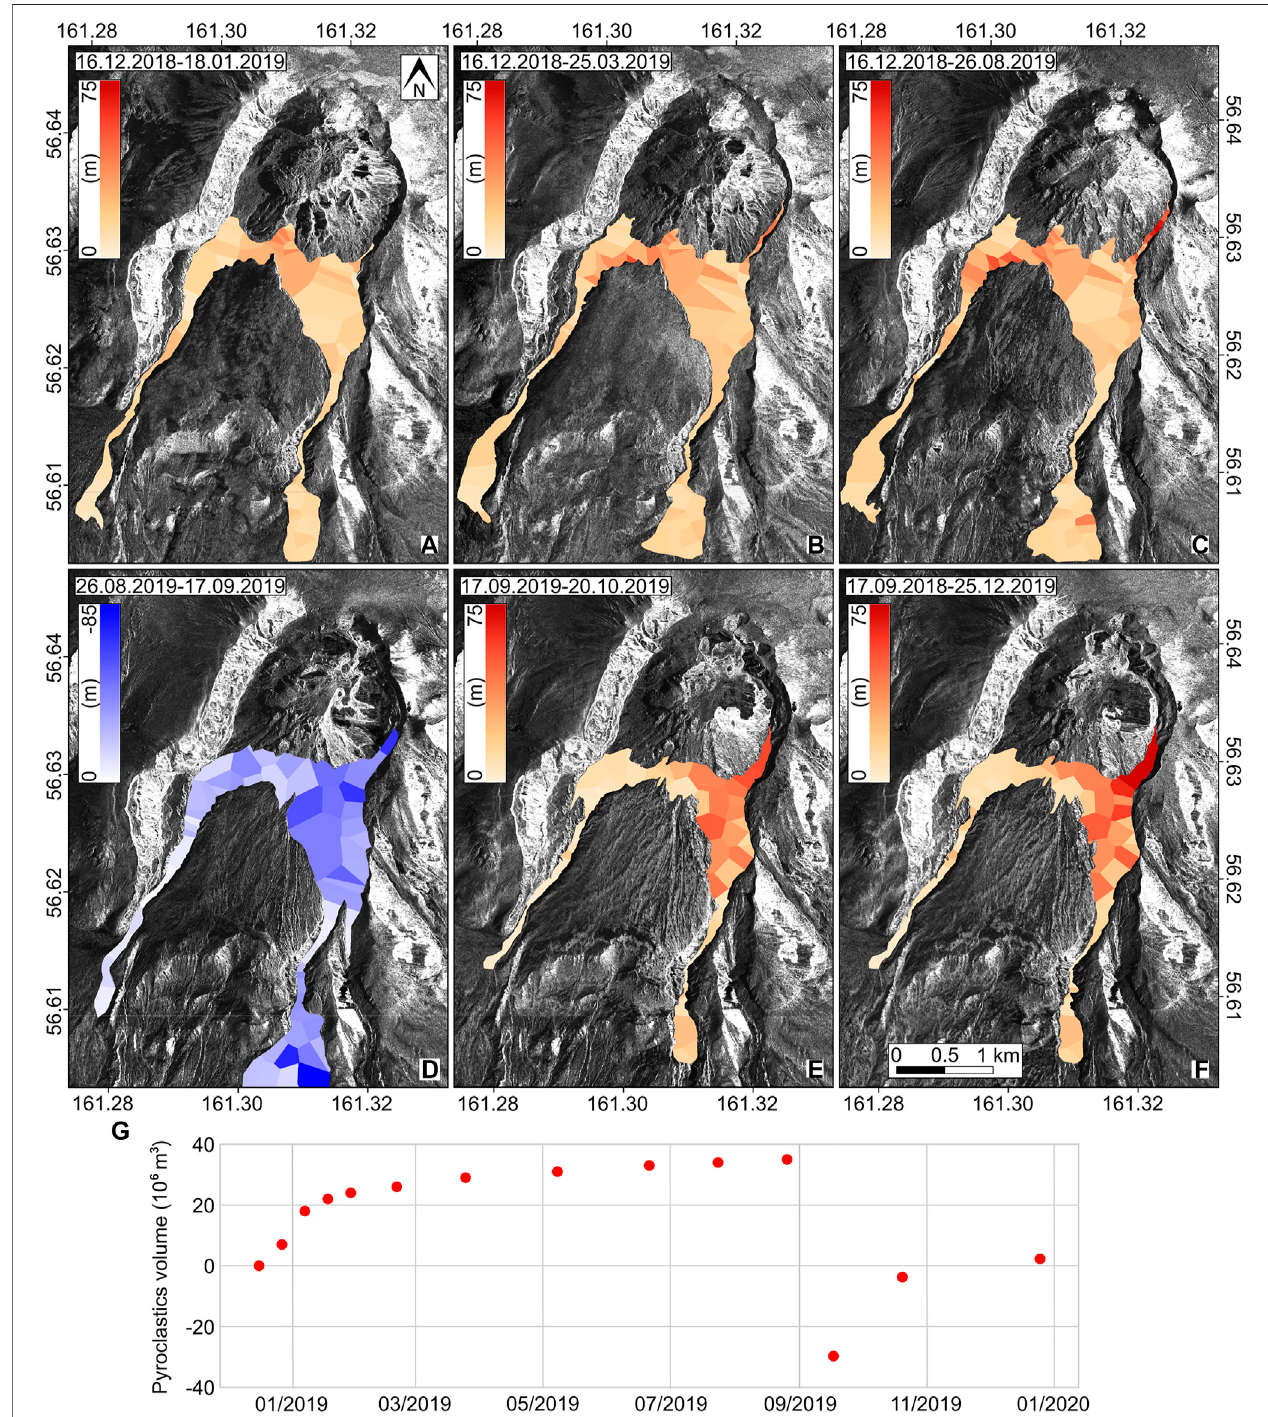
FIGURE 9 | Time series of the minimum deposit thickness within the 2005 and 2010 collapse scars estimated using the radar shadow method for several SAR acquisitions between December 2018 and December 2019 (see Data and Methods SAR Data and Monitoring the Material Redistribution ( b )). Reddish and bluish polygons show the Voronoi diagram approximations of the area of accumulation and removal of material, respectively (A – C) show the fi rst period of deposition starting from thedome reactivation inDecember 2018uptojustbefore theAugust29,2019explosionestimatedwithrespecttotheDecember 16,2018image (D) shows the material removal episode that occurred after the explosion estimated in relation to the August 26, 2019 image (E,F) show the successive material accumulation episodesestimated inrelation totheSeptember 17,2019image. Asthebackgroundimages for (A – F) ,thedatesofthecompared geocodedTSXimagesaredisplayed; (G) presents the time series of the deposit volume change; all values are relative to the December 16, 2018 image.